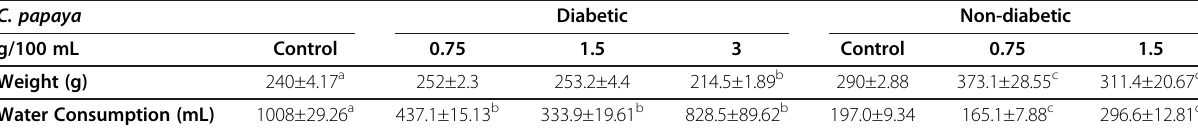
Table 1 Effect of aqueous extract of C. papaya leaf on body weight and water consumption in diabetic and non- diabetic